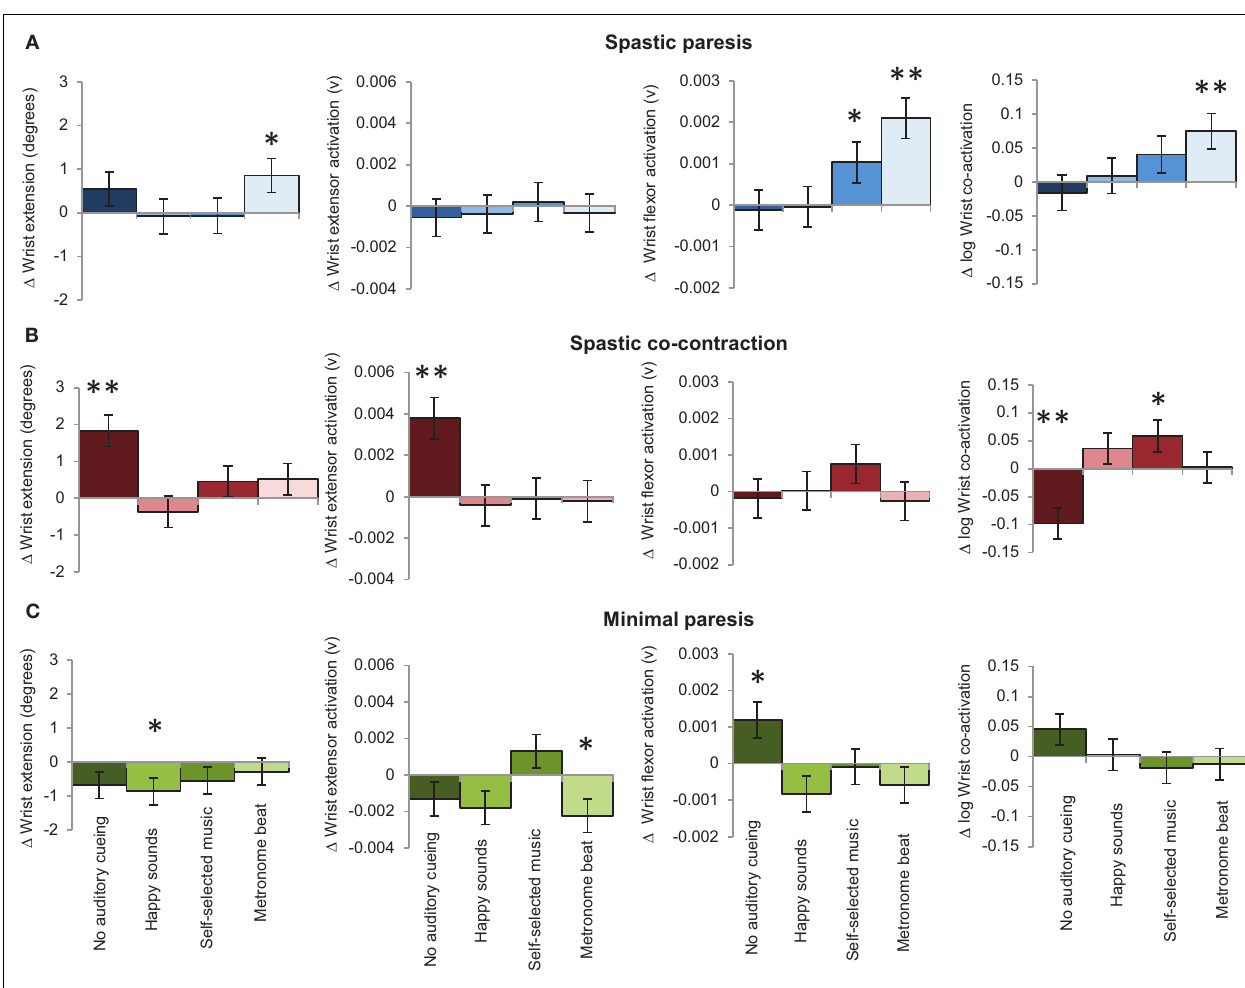
FIGURE 6 |The bars represent the mean slopes showing the effect of auditory stimulation on bimanual-to-unimanual learning for wrist extension performance variables in the three groups: (A) spastic paresis (blue); (B) spastic co-contraction (red); (C) minimal paresis (green) . Error bars represent the standard error. **Represents differences between the three groups at p < 0.01, and *represents differences between the three groups at p <